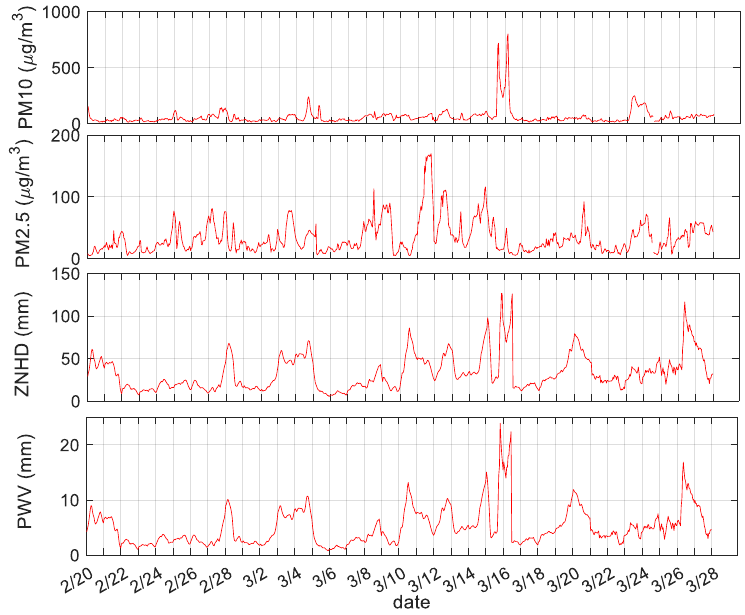
Figure 4. Changes in PM10, PM2.5, ZNHD and PWV at CHAN station.